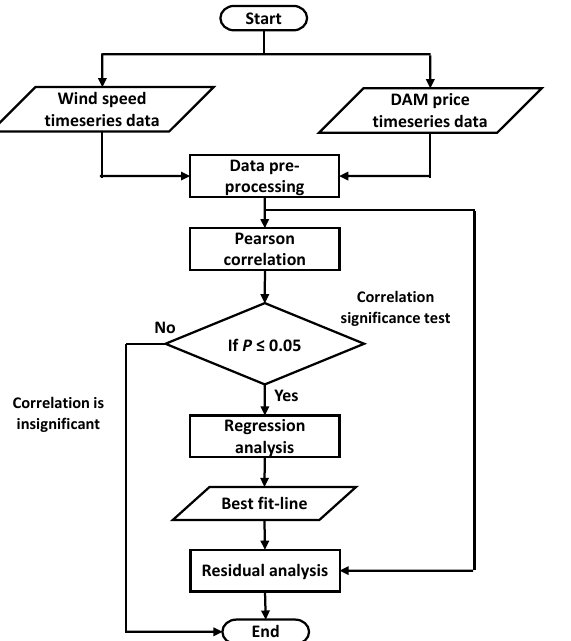
Figure 5. Flowchart of the correlation modelling method of DAM price and wind